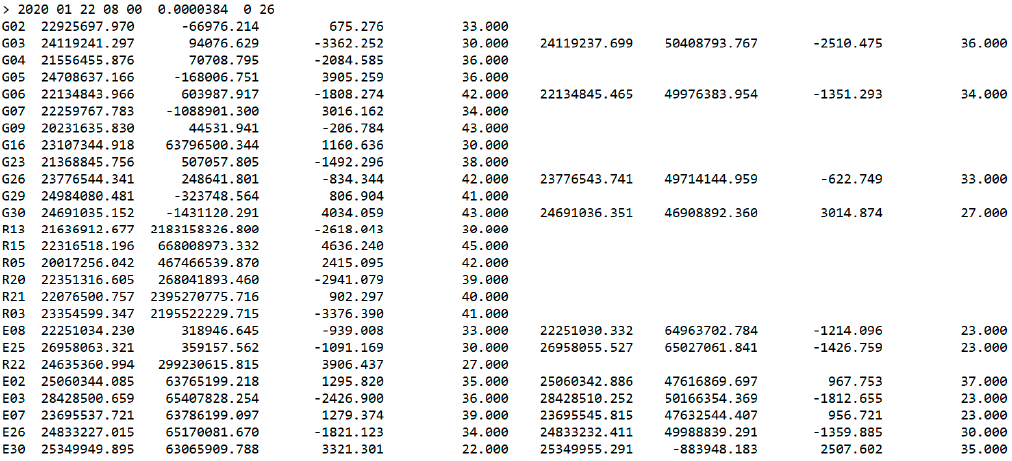
Figure 1. Single epoch for a Huawei P30 Pro smartphone collected in RINEX 3.03 (Receiver Independent Exchange Format 3.03).